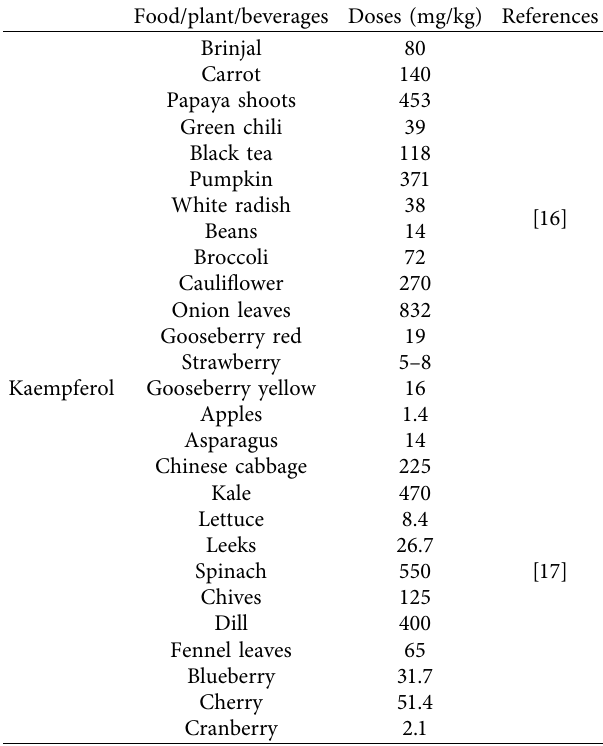
Table 1: Dietary sources of kaempferol. Food/plant/beverages Doses (mg/kg)